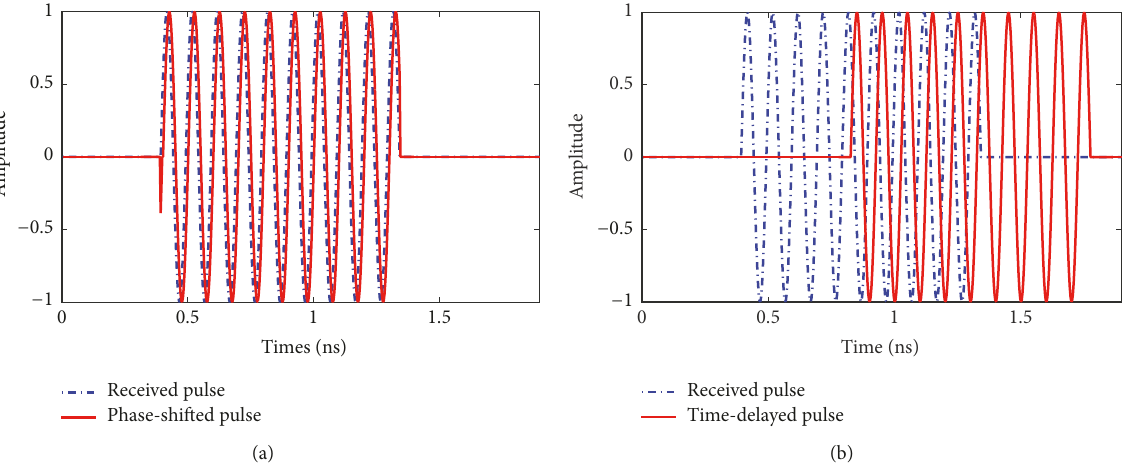
Figure 11: The received pulse at element 10 of a 20-element array is (a) phase-shifted and (b) time-delayed.